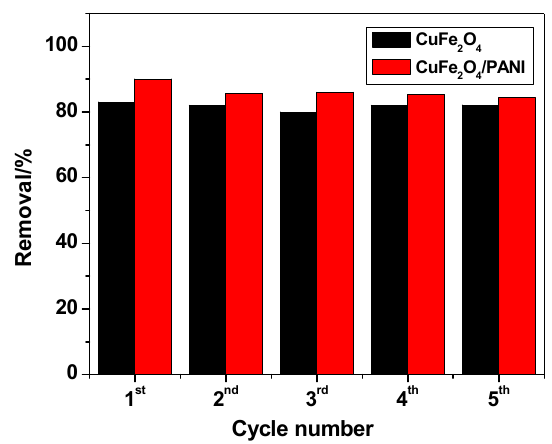
Figure 11. Mercury removal by CuFe 2 O 4 and CuFe 2 O 4 / PANI nano-composites after regeneration.